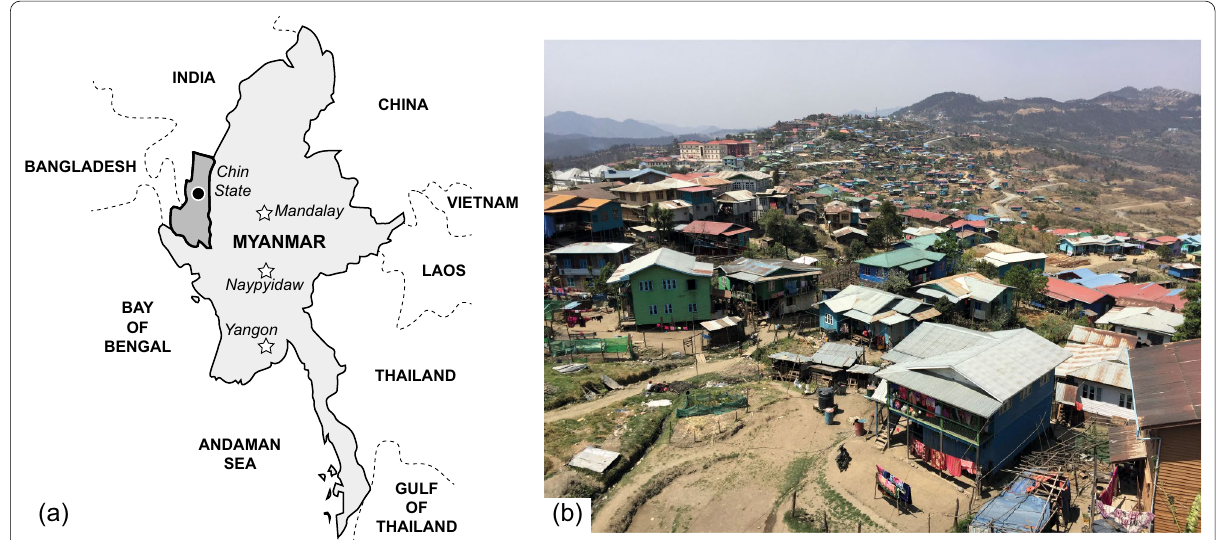
Fig. 1 a Diagram of Myanmar showing the location of Chin State (the black circle shows the location of Hakha), and b photograph of